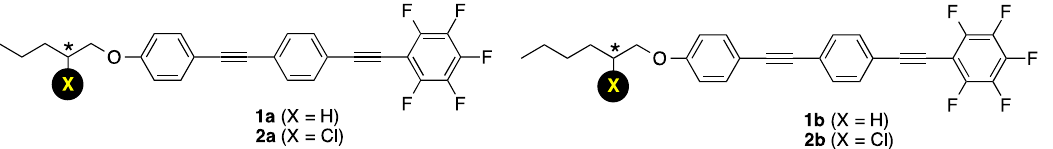
Figure 2. Chemical structures of bistolanes 1a – b and 2-chloroalkoxy-substituted 2a – b investigated in this